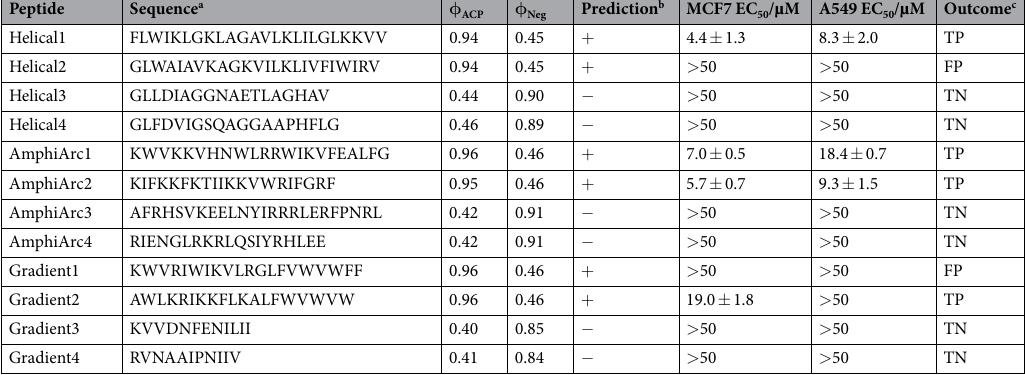
Table 4. Experimental validation of the SVM prediction model. The peptides from each virtually designed library were evaluated according to a similarity-weighted score for belonging to the positive ( φ ACP ) and negative ( φ Neg ) class. The two peptides with the highest φ ACP and φ Neg scores for each library were synthesized and tested for anticancer activity on breast adenocarcinoma (MCF7) and lung adenocarcinoma (A549) cell lines (EC 50 , mean ± std , N = 3). a All peptides were synthesized with amidated C-termini; b Prediction: + predicted to be active, − predicted to be inactive; c Outcome: TP: true positive, FP: false positive, TN: true